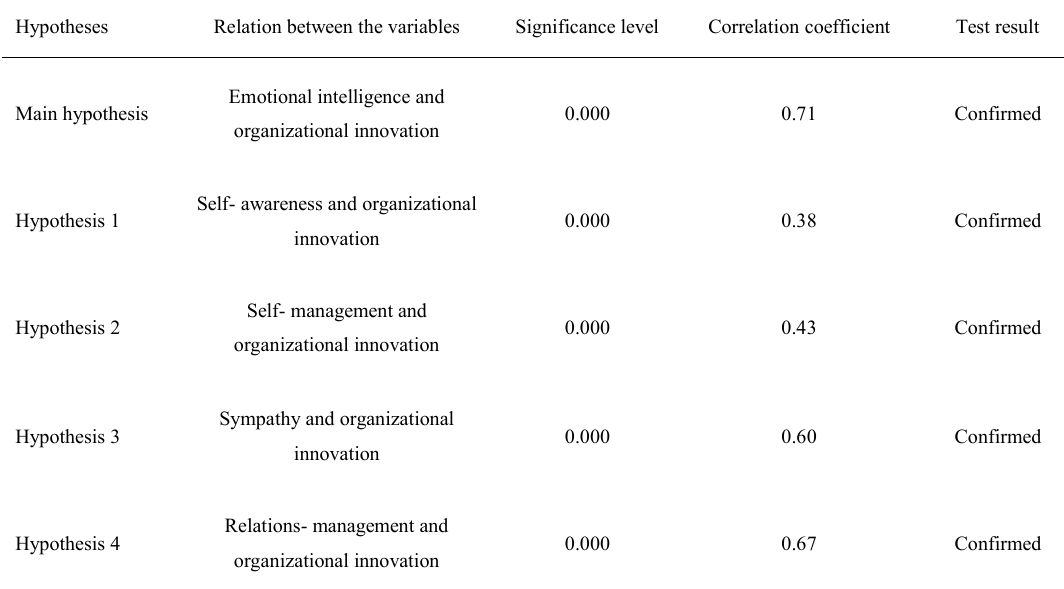
Table 4: Results of correlation coefficient